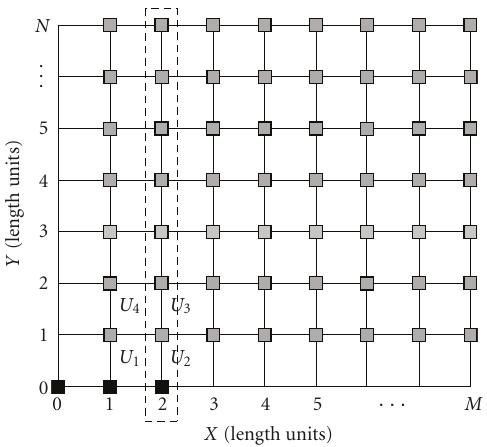
Figure 3: Schematic of position of anchor